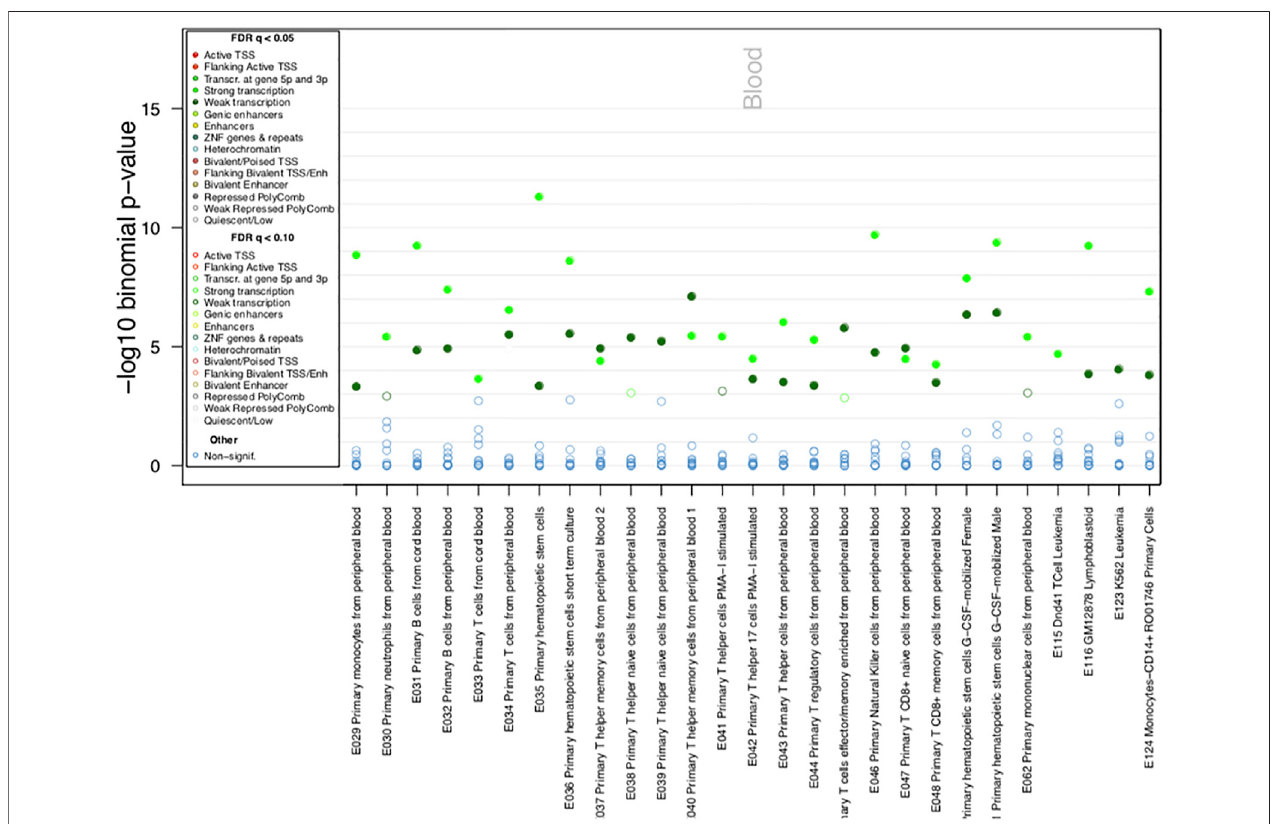
FIGURE 3 | ChromHMM Functional annotation of identi fi ed DMPs. Chromatin state enrichment in blood cells as calculated by eFORGE software.